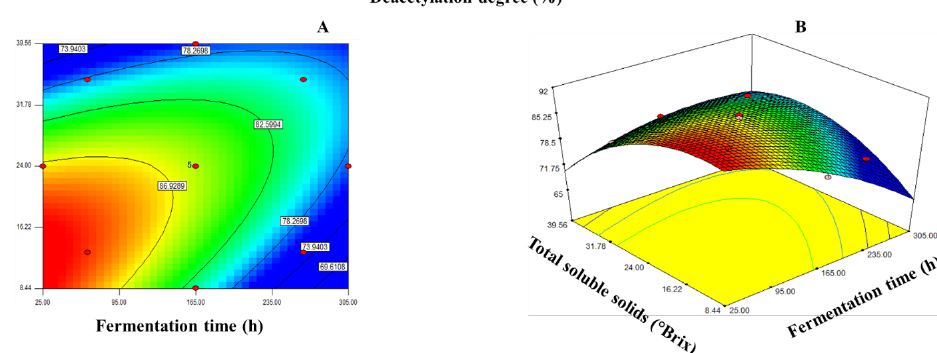
Figure 1. Contour plots and response surface ( A , B ) for the effect of fermentation time (h) and total soluble solids (°Brix) on the deacetylation degree of chitosan.